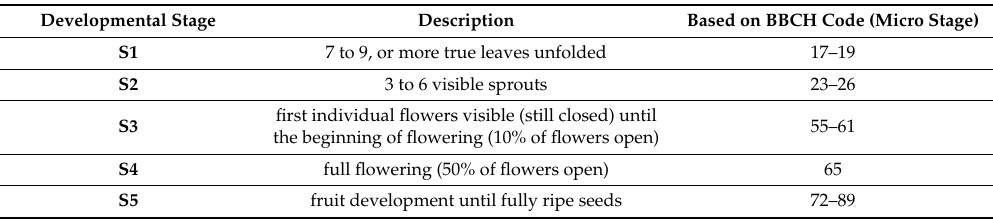
Table 2. Definition and description of the stages of development for Senecio vulgaris L. to be sampled, based on the BBCH monograph of Meier [73].